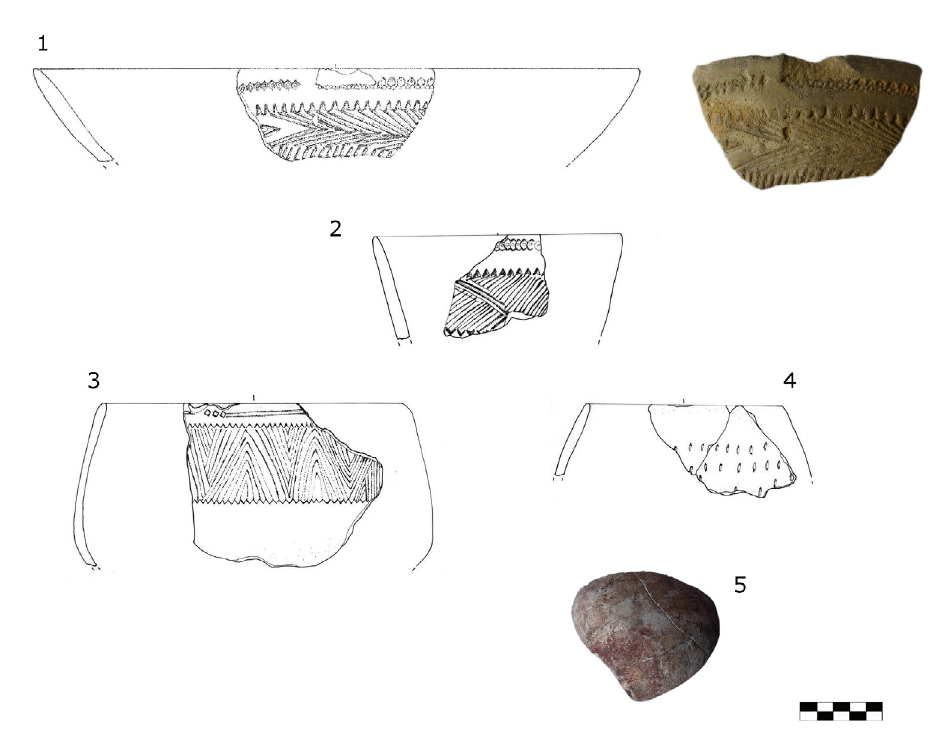
Figure 7. S. Martino. Stentinello pottery. 1–4. Fine Impressed Ware class (bowls and cups). 5. Figulina pottery class (depurated clay) with traces of red